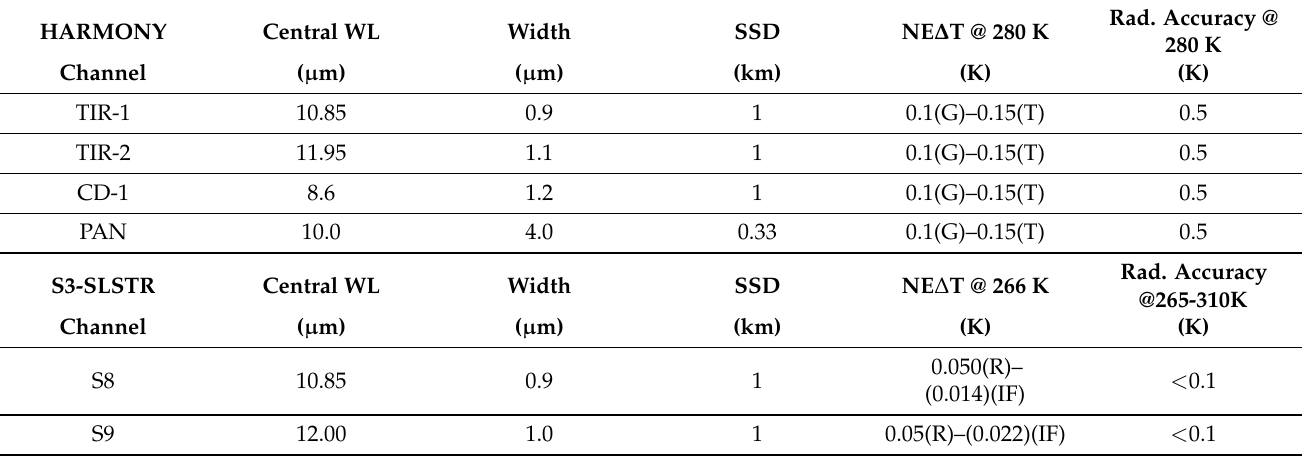
Table 1. Relevant characteristics of the Harmony TIR imager channels and, for reference, the Sentinel 3 SLSTR equivalent to TIR-1 and TIR-2. For the Harmony NE ∆ T, “G” and “T”, respectively, stand for goal and threshold. For the SLSTR NE ∆ T, “R” and “IF”, respectively, stand for require- ment and in-flight performance value, following [26]. In this table, WL = wavelength, SSD = spatial sampling distance, NE ∆ T = noise-equivalent ∆